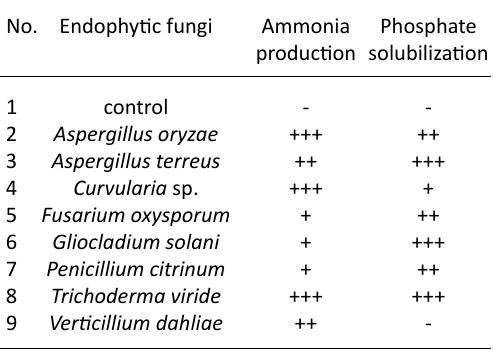
Table 6. Ammonia production and phosphate solubilization of endophytic fungi